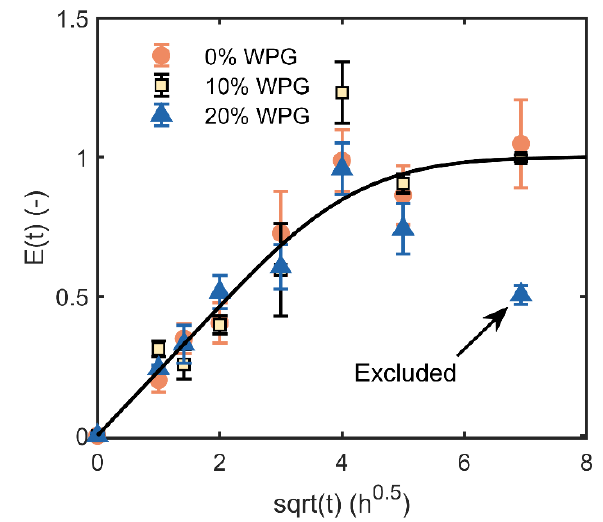
Figure 4. Iron(III) uptake from acetate solution plotted as E ( t ), or the fractional change in concentration, as a function of the square root of time along with the model fit. as a function of the square root of time along with the model